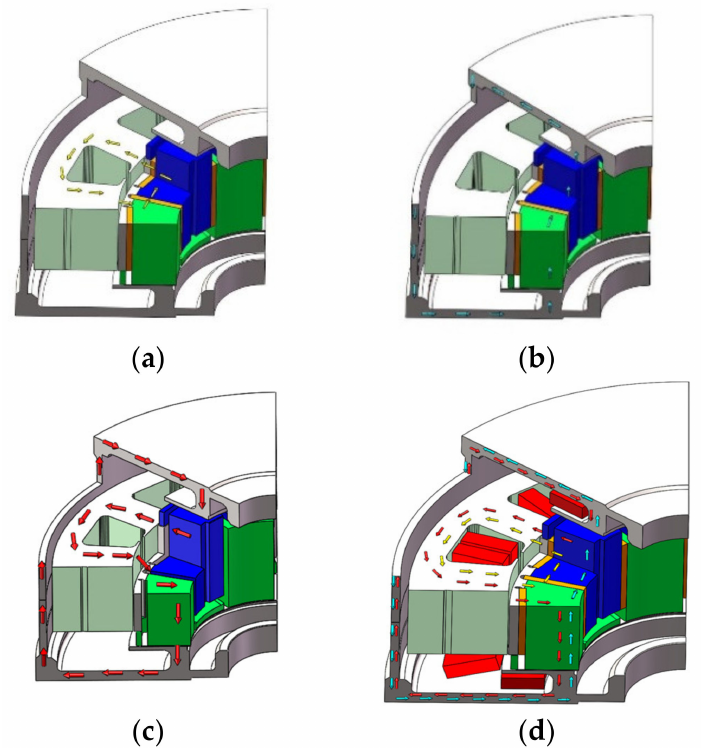
Figure 5. Hybrid flux path in HECPG: ( a ) first permanent magnet (PM) flux path; ( b ) second PM flux path; ( c ) field excitation flux path; ( d ) hybrid flux